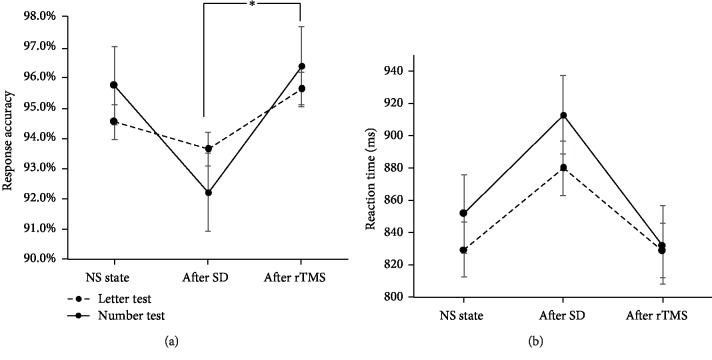
Response accuracy (a) and reaction time (b) of letter and number and spatial position working memory assessment after normal sleep, SD, and rTMS treatment. NS: normal sleep; SD: sleep deprivation; rTMS: repetitive transcranial magnetic stimulation. ∗ represents p < 0.05.